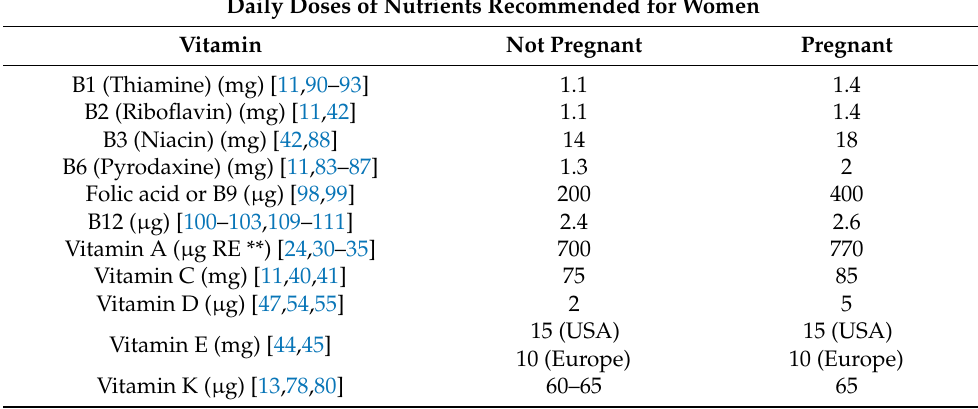
Table 2. Recommended daily dose of vitamins in